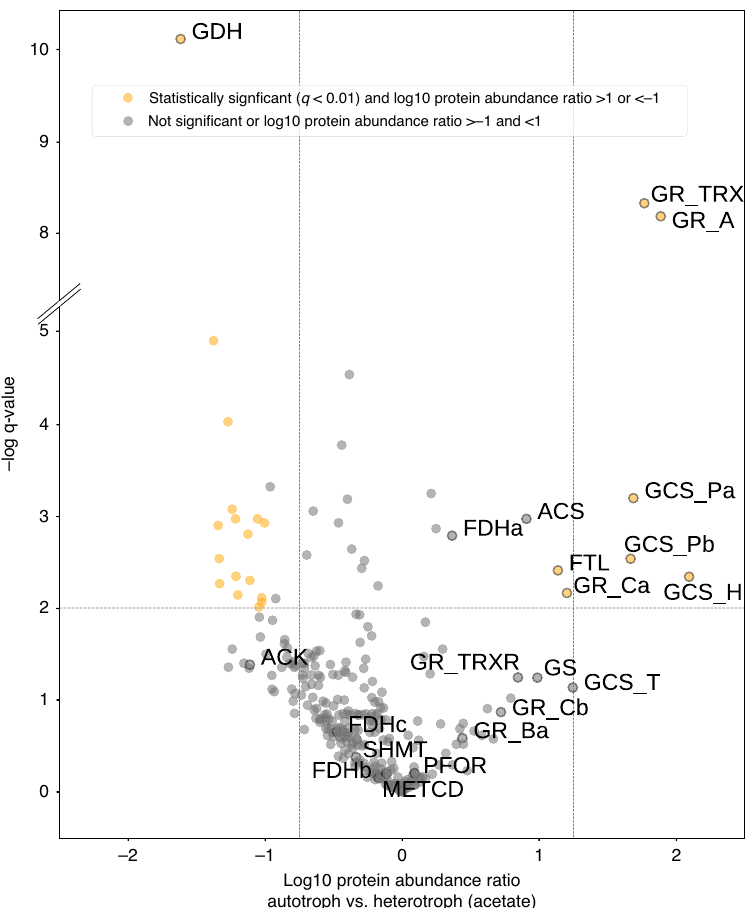
Fig. 2 Volcano plot for protein up-regulation of autotrophic vs. heterotrophic growth conditions. Autotrophic (H 2 /CO 2 /sulphate) and heterotrophic (acetate/H 2 /CO 2 /sulphate) cultivations were performed in four biological replicates to perform proteomic analysis. Growth conditions were 30 °C